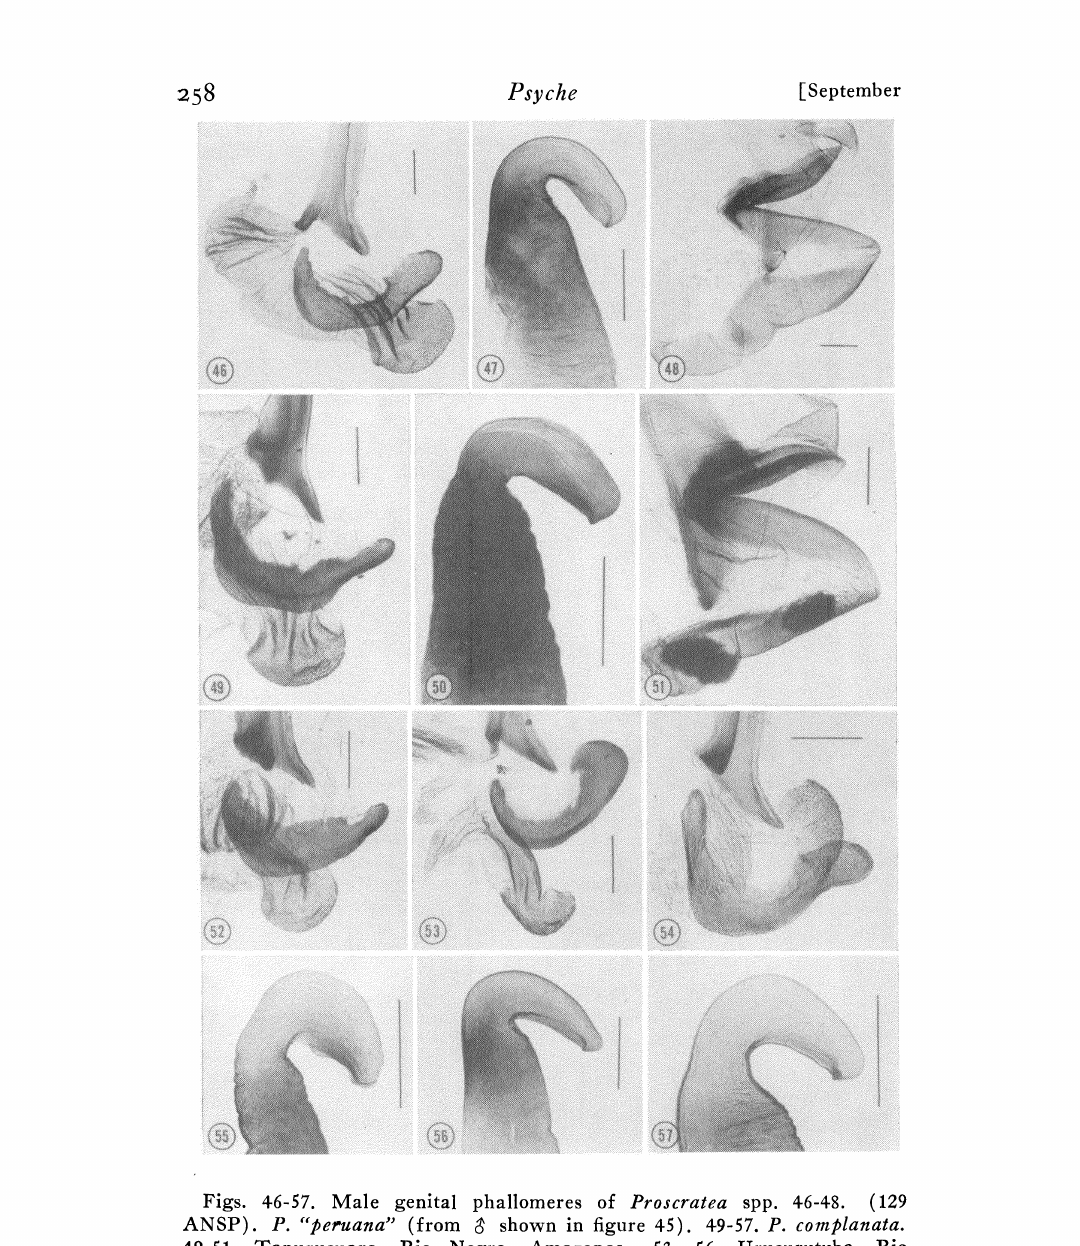
Figs. 46-57. Male genital phallomeres of Proscratea spp. 4.6-48. (129 ANSP). P. "leeuana" (from shown in figure 45). 49-57. P. complanata. 49-51. Tapurueuara, Rio Negro, Amazonas. 53, 56. Urueurutuba, Rio Madeira, _Amazonas. 54, 57. Serra Tamendaui, Rio Negro, Amazonas. (scale 0.2